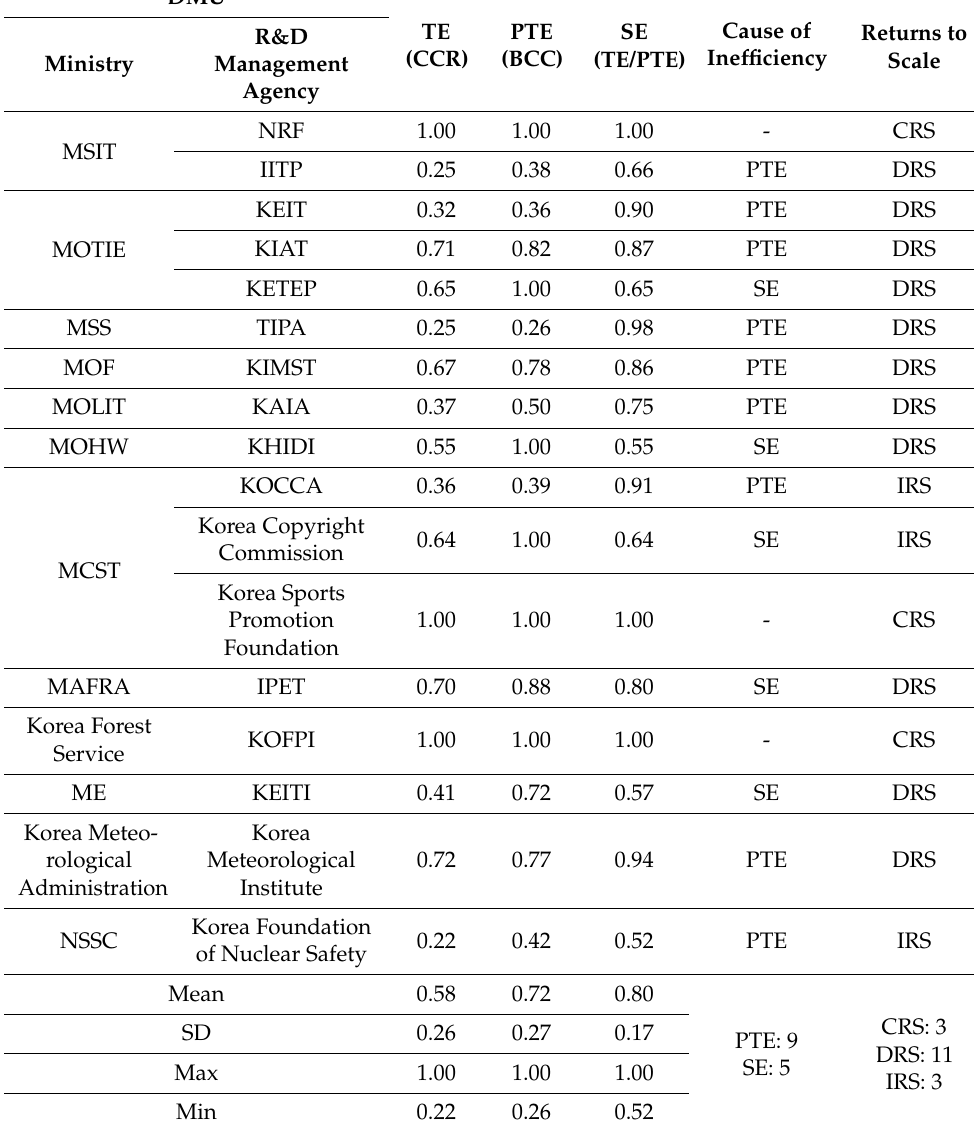
Table 9. Efficiency analysis results of R&D